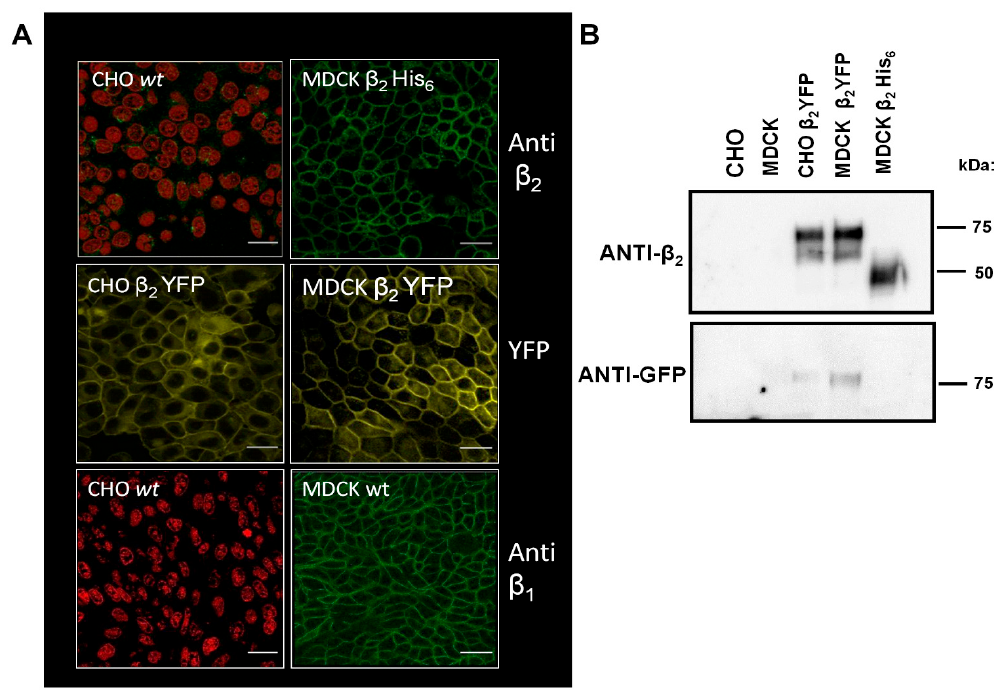
Figure 2. Generation and description of CHO and MDCK cells expressing the β 2 subunit . ( A ) Stable cell lines expressing the β 2 subunit, tagged with the Yellow fluorescent protein ( β 2 YFP) and with 6xHis tag ( β 2 His 6 ) were created from CHO-K1 cell line (CHO β 2 YFP) and from MDCK cell line (MDCK β 2 His 6 and MDCK β 2 YFP). Immunofluorescence images of wild type CHO cells and MDCK β 2 His 6 cells assayed for β 2 expression by a specific anti- β 2 antibody are shown in upper panels. Fluorescent images of β 2 YFP expressed in CHO and MDCK cells are shown in middle panels. Immunofluorescent images of β 1 subunit expression assayed with a specific anti- β 1 antibody in wild type CHO and MDCK cells are shown in lower panels. Nuclei are stained with propidium iodide in red (bar scale 50 μ m). ( B ) Western blot analysis of Wild type and transfected cells (as indicated in each lane) for the expression of β 2 subunit (upper panel) and for YFP expression (lower panel).